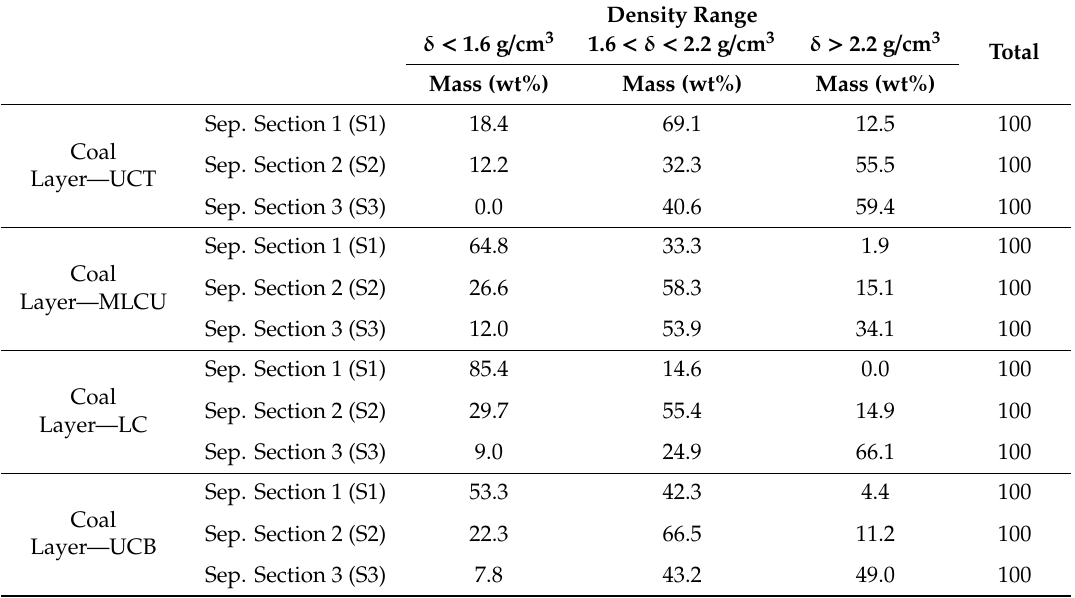
Table 3. Masses (wt%) in densities fraction ( δ < 1.6 g / cm 3 , 1.6 < δ < 2.2 g / cm 3 , and δ > 2.2 g / cm 3 ) directed to the three Separation Sections after jigging, for the four coal